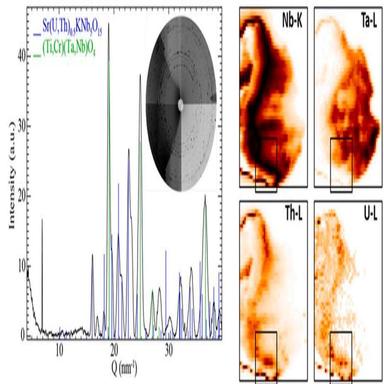
μ-XRD and μ-XRF analysis of a sample from the Bolladalen site. The XRD diffractogram on the left are recorded in the box marked in the XRF elemental maps on the right, where the higher Th and U intensities are detected.